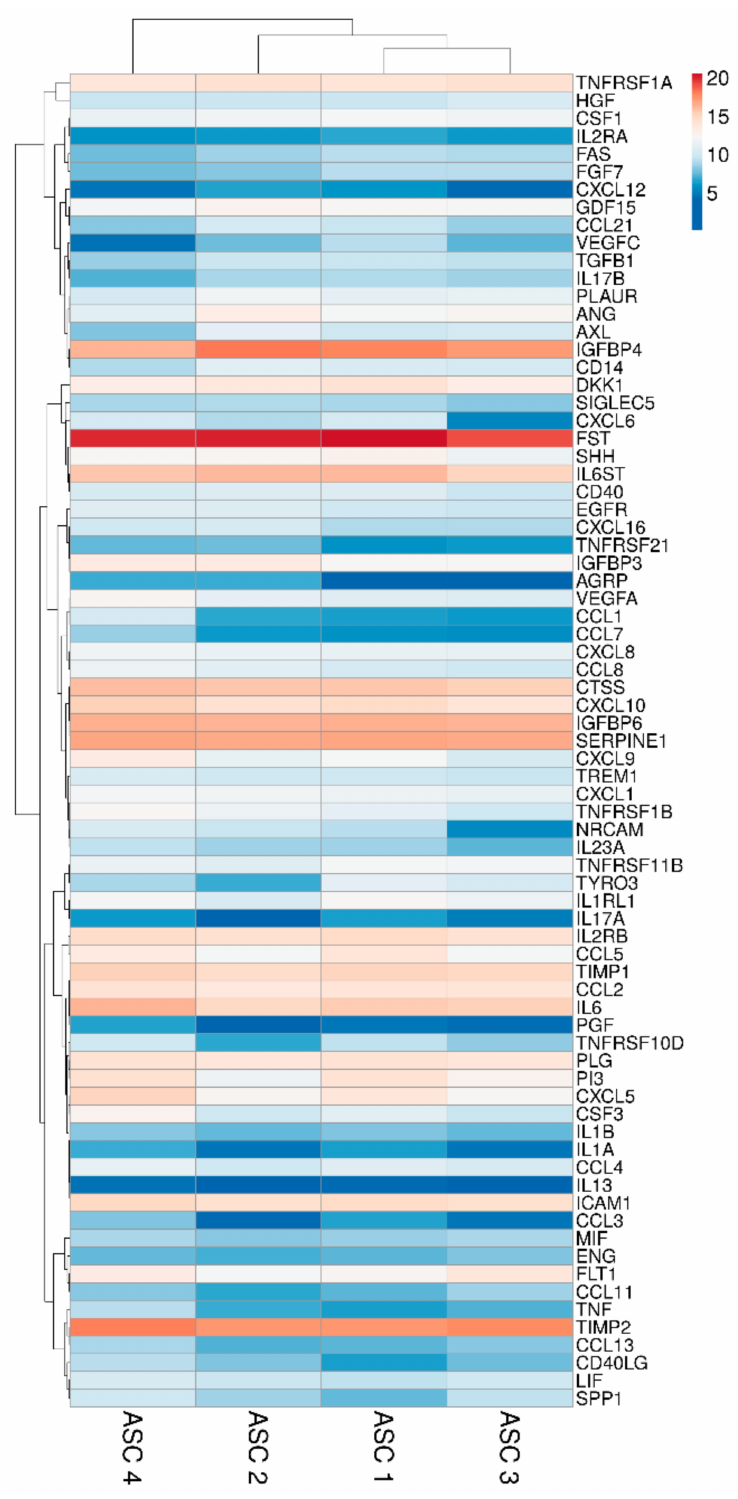
Figure 2. Heat map of ASCs-secreted factors across all samples. Heat map of hierarchical clustering analysis: the log 2 values of 75 detected secreted factors after normalization per 10 6 ASCs. The sample clustering tree is shown at the top. The color scale shown in the map illustrates the absolute expression levels of factors across all samples: red shades = high expression levels (high log 2 (pg) per 10 6 ASCs) and blue shades = lower expression levels (low log 2 (pg) per 10 6